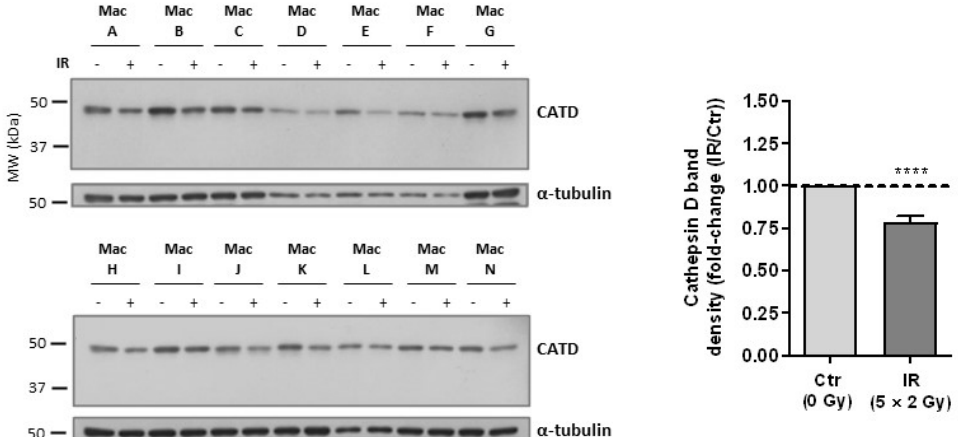
Figure 2. Validation of cathepsin D downregulation in irradiated macrophages (5 × 2 Gy), compared with non-irradiated controls. Western blot analysis of the same donors used for iTRAQ ( n = 4, Mac A–D) and of additional donors ( n = 10, Mac E–N). The graph depicts the quantification of cathepsin D band intensity, normalized to α -tubulin staining (fold-change: IR/Ctr). Data are represented as the mean ± SEM (**** p < 0.0001). A one-sample t -test was used for statistical analysis. The whole blots (uncropped blots) showing all bands with all molecular weight markers on the Western are provided in the Supplemental Materials.